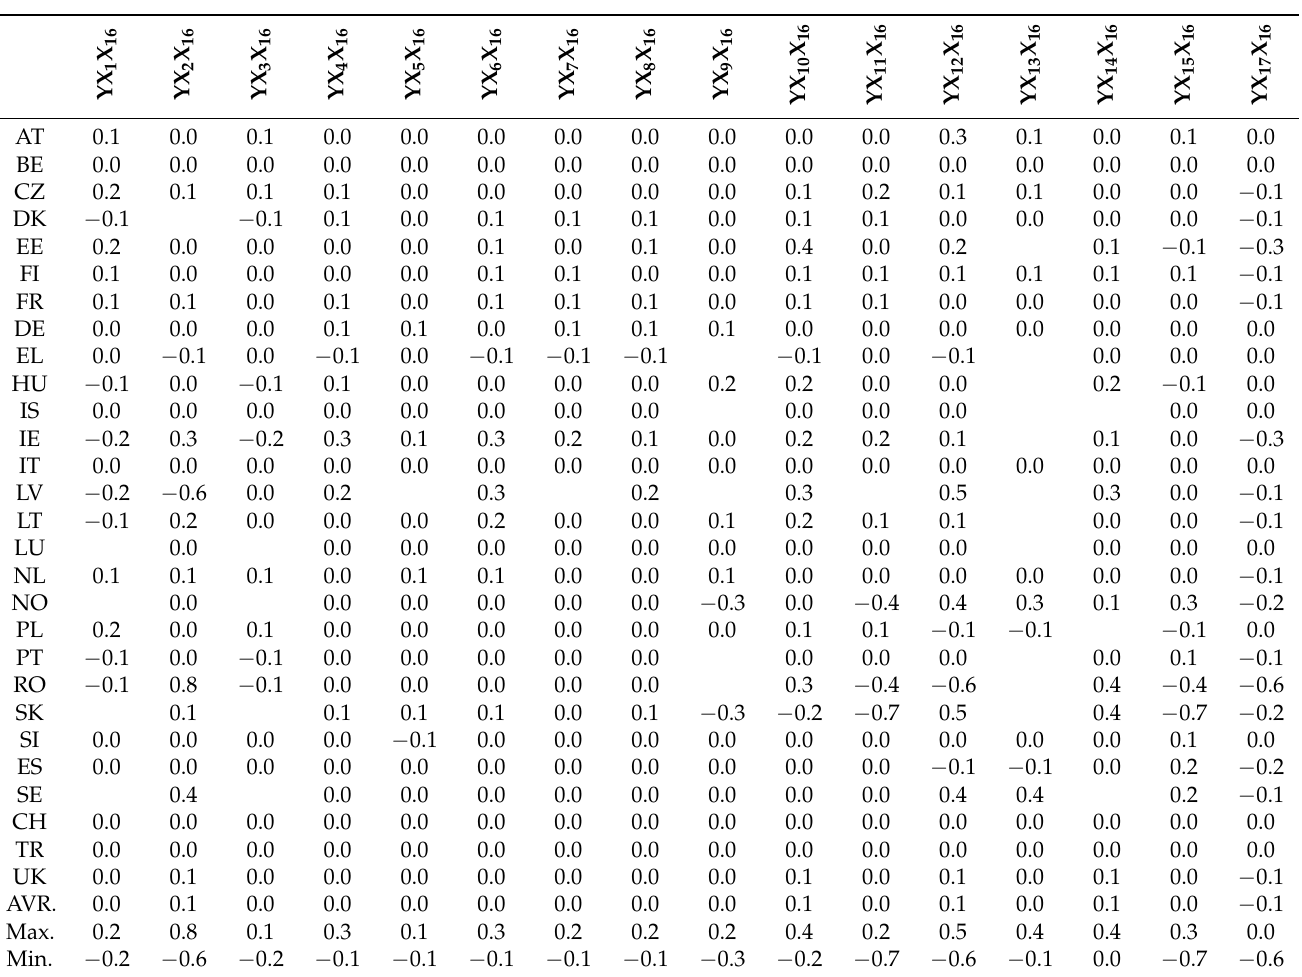
Table 12. Tri-dimensional synergy—YX i X 16